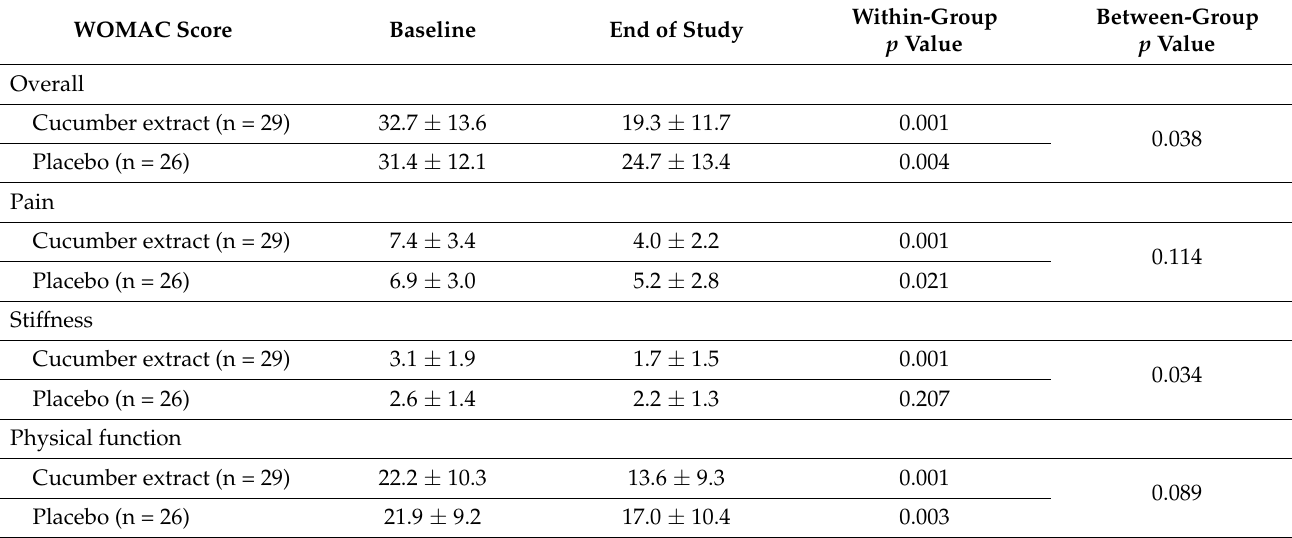
Table 4. Changes in WOMAC scores in the study